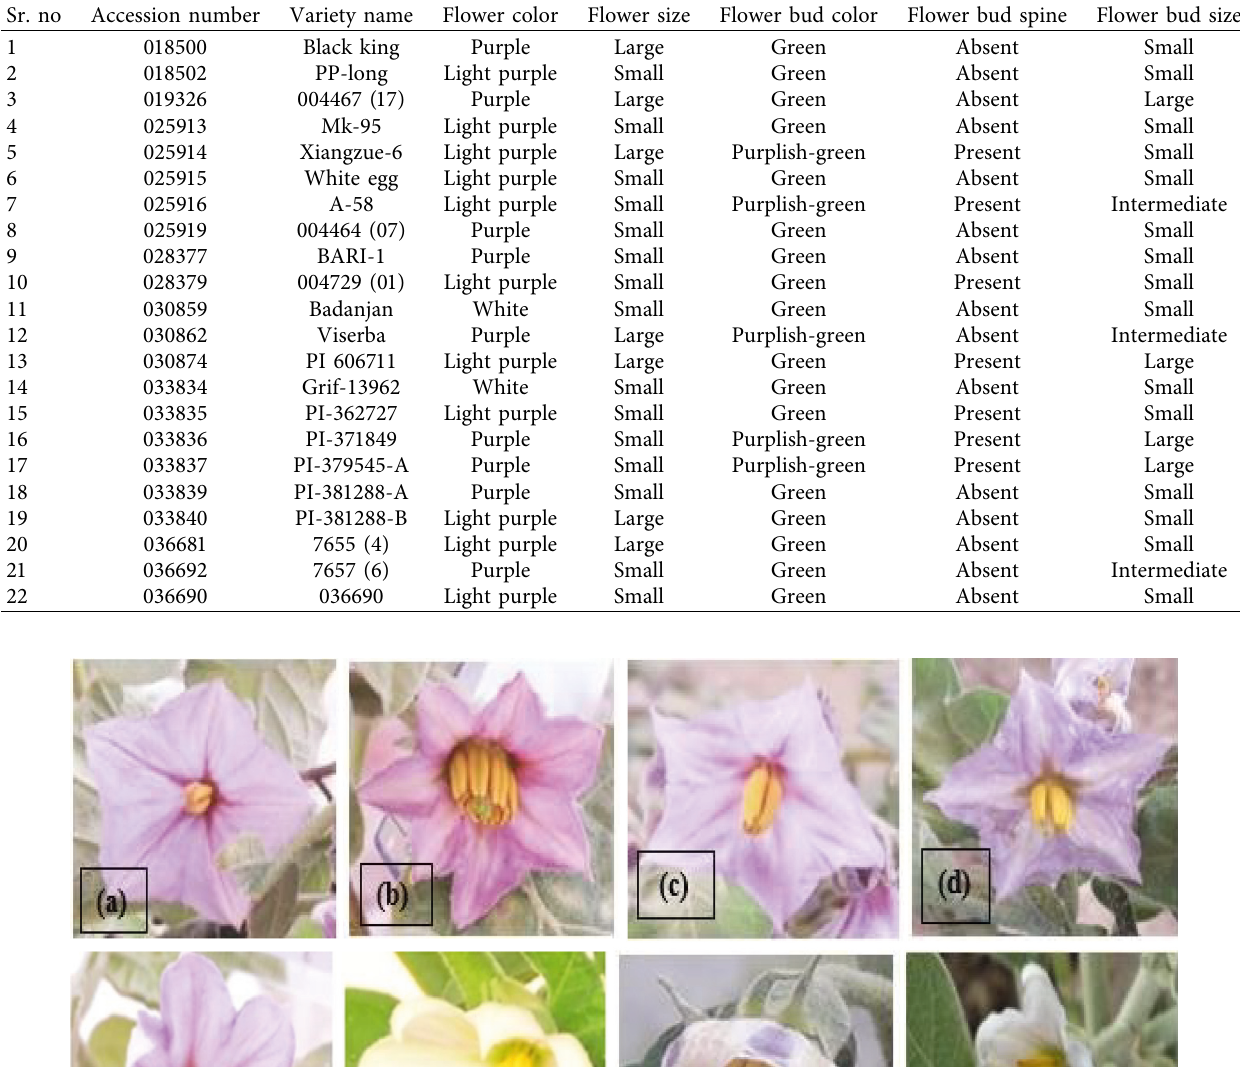
Table 4: Morphological variation in flower traits of 22 eggplant